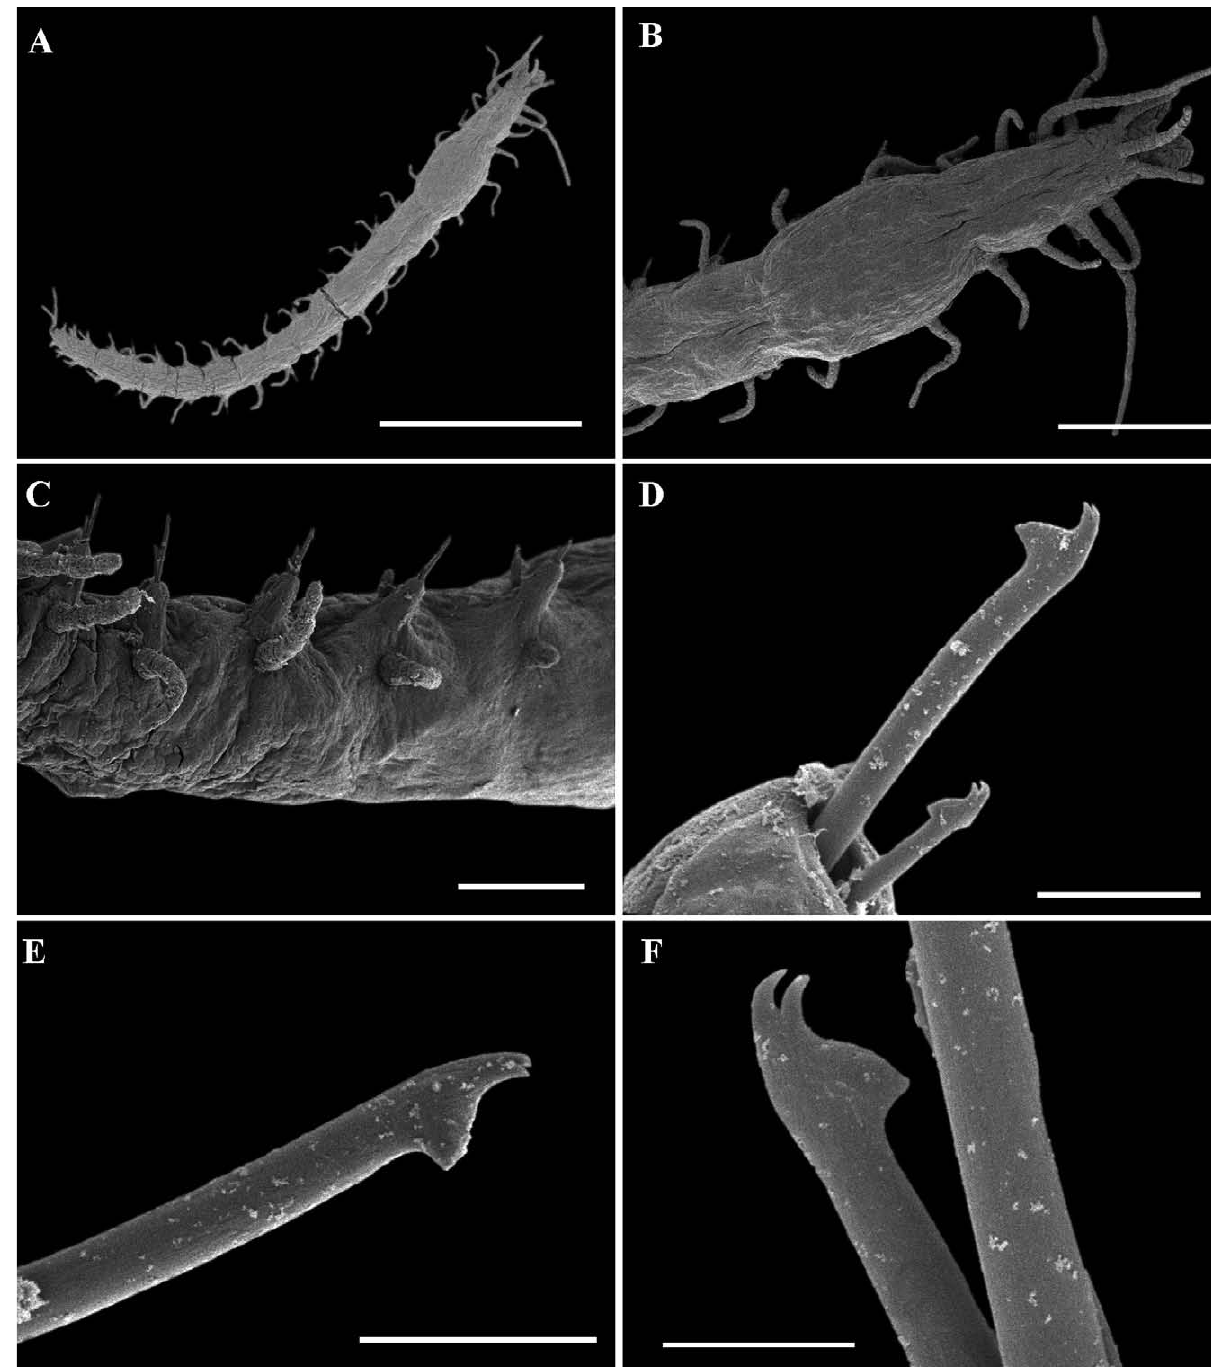
Fig . 14. – SEM micrographs of Haplosyllis navasi n. sp. A, whole body, dorsal view. B, anterior end, with broad proventricle. C, mid-body parapodia. D, posterior chaetae. E, mid-body large chaeta. F, mid-body, small chaeta. Scale bars: A (1 mm) B (300 m m), C (100 m m), D-E (10 m m), F (5 m m). INV−ANE